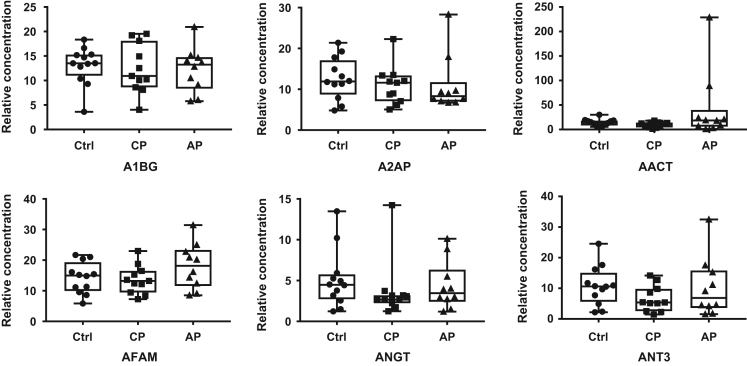
Graphic results of normalized protein levels for the protein multiplex. All the proteins were presented as medians and interquartile ranges. Statistical analysis (Mann-Whitney test) was used to evaluate the significance of the difference between the groups.